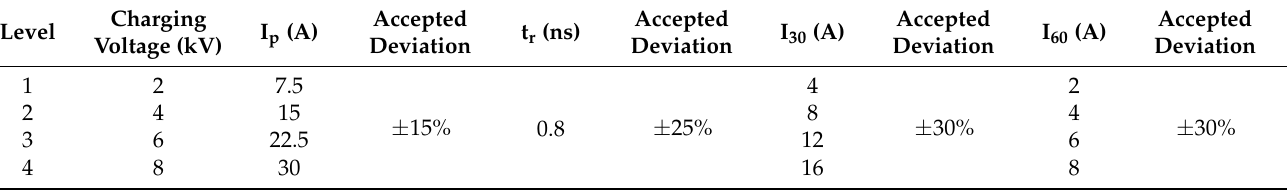
Table 1. Waveform parameters of the ESD current for contact dicharges.